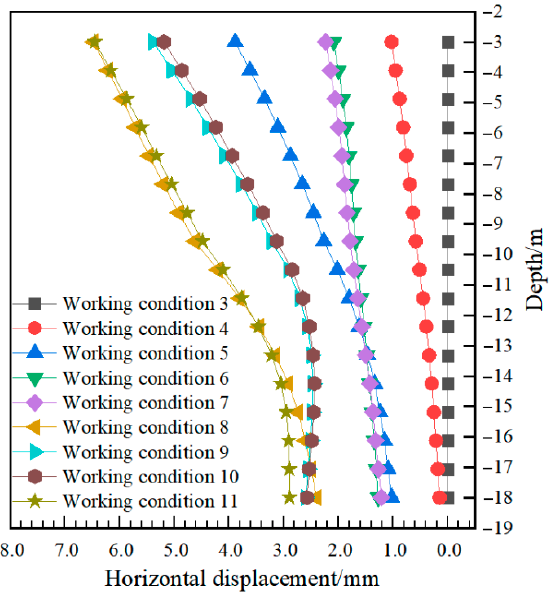
Figure 22. Changes in the horizontal displacement of supporting piles under different working conditions.